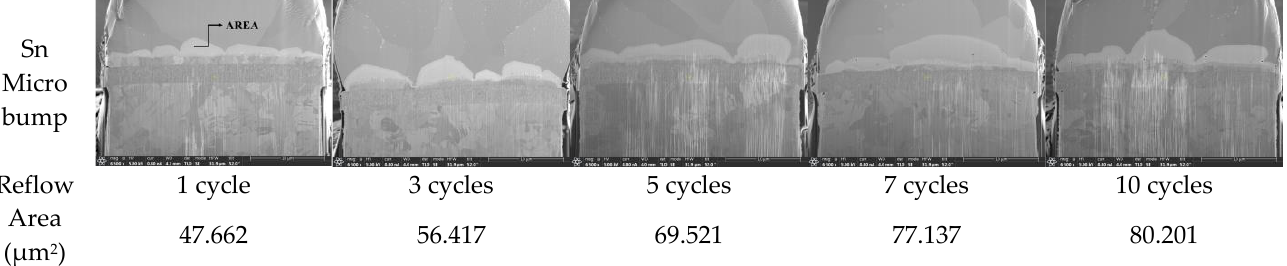
Figure 13. Cross-sectional shape and area of the micro bump.